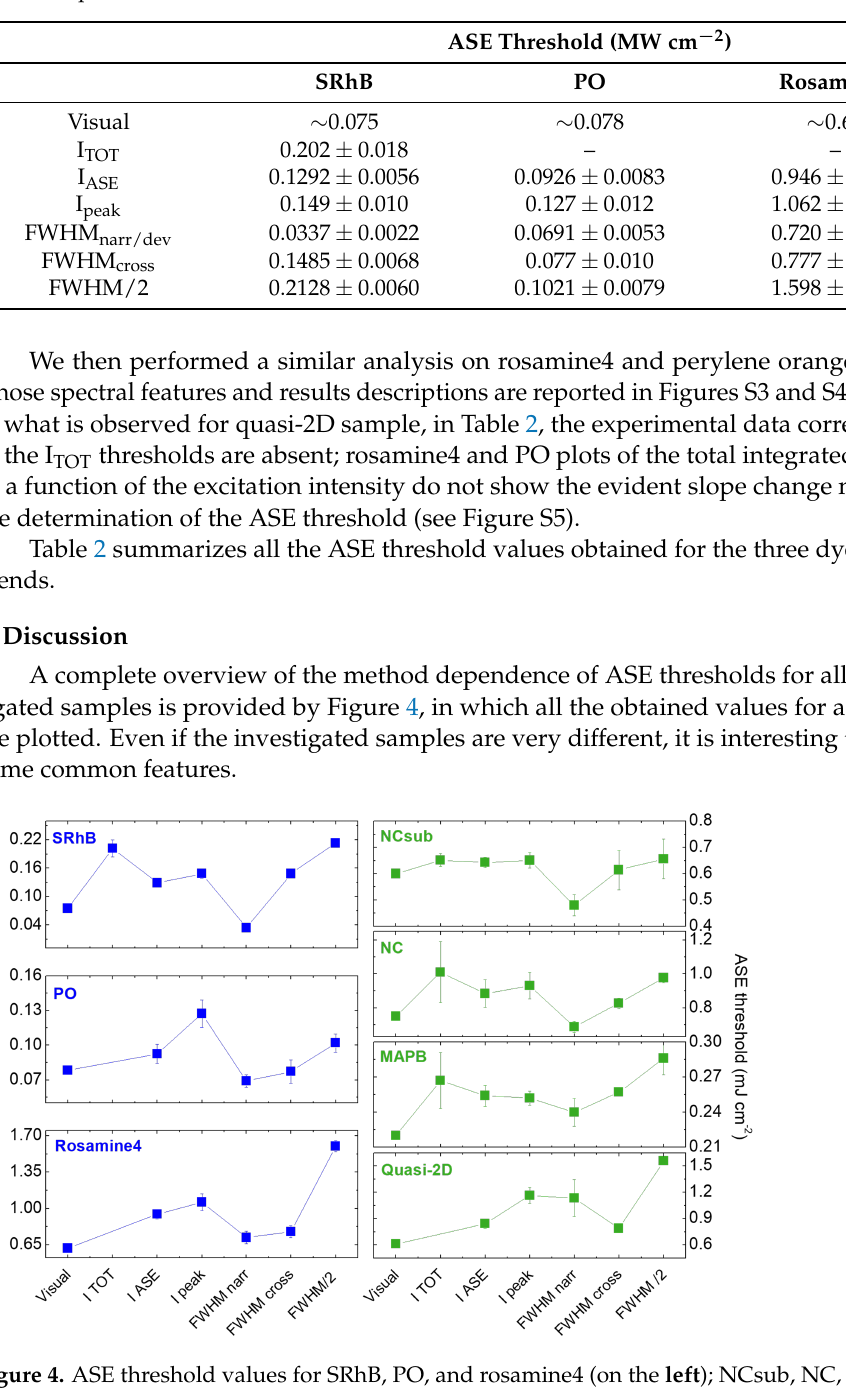
Table 2. ASE threshold values obtained from the application of all the methods for dye-polymer blend samples.